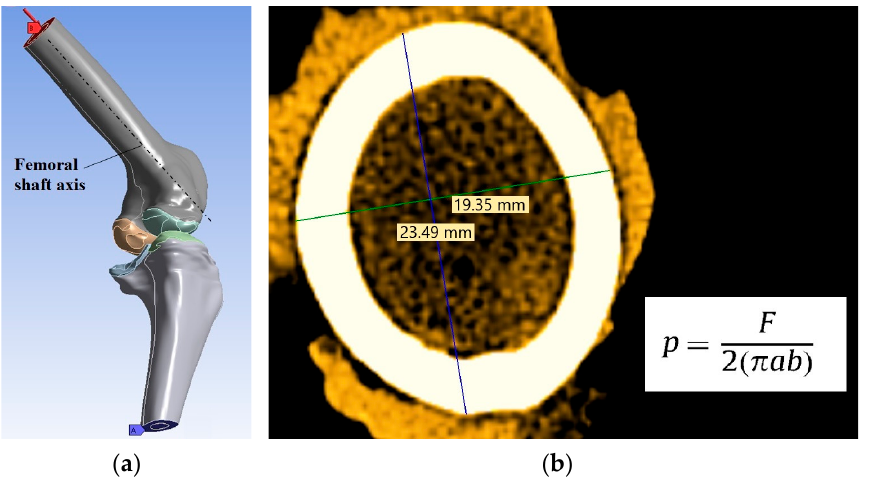
Figure 3. ( a ) FEA conditions: A—Constraint zones (blue area), B—Pressure zone and its direction (red area); ( b ) Femur cross-section and equation used to calculate the pressure. The knee joint force was applied on the bottom plane of the femur as a pressure ( p ) calculated with the equation detailed in Figure 3b, where F is the normal force on the whole knee joint, a and b are the major and minor axes lengths of the elliptical cross section of the femur. The force acting on the sheep’s knee joint is 2.1–2.25 times the weight of